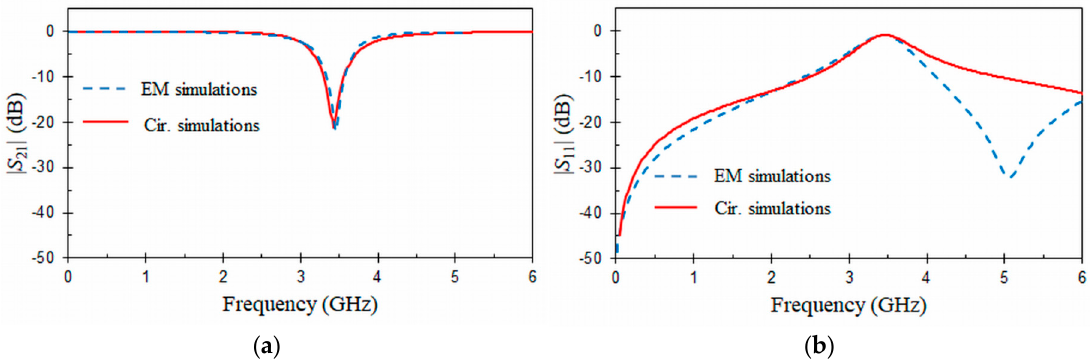
Figure 7. EM and circuit frequency responses for the CPW structure loaded with an ORR cell ( a ) | S 21 | (dB) and ( b ) | S 11 | (dB). Dimensions (mm) and permittivity: r =1.9, c = 0.3, g = 0.2, D 1 × D 2 = 9 × 9, W = 0.374, S = 0.163, L 1 = 5.5, t = 0.017, h = 0.635, and ε r = 10.2 (tg δ =